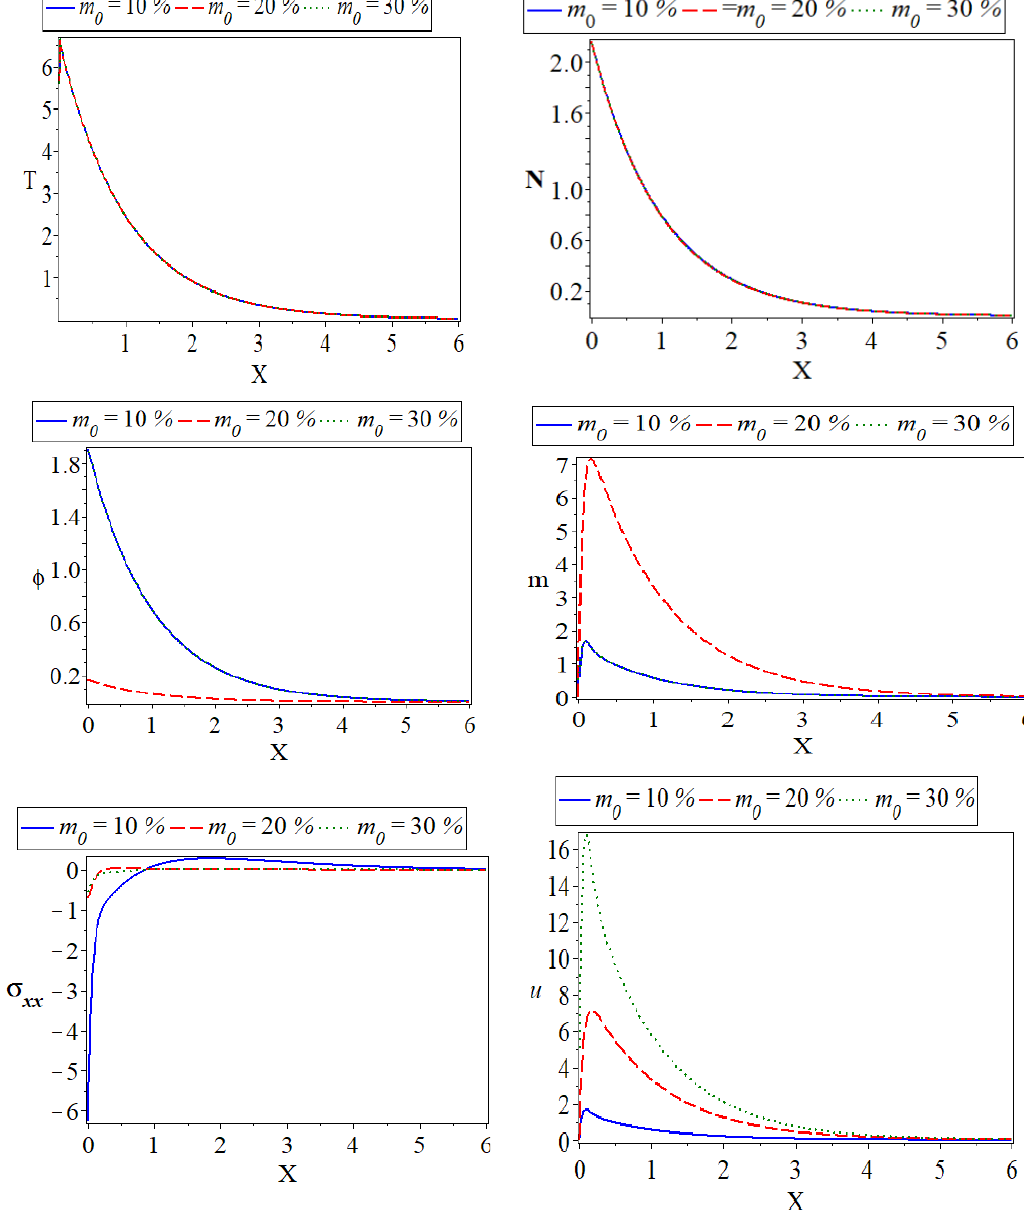
Figure 4. The variation of physical field distributions with distance at different values of the reference moisture m 0 under the effect of magnetic field when ε 1 = 0.001 and ε 3 = − 7.8 × 10 − 36